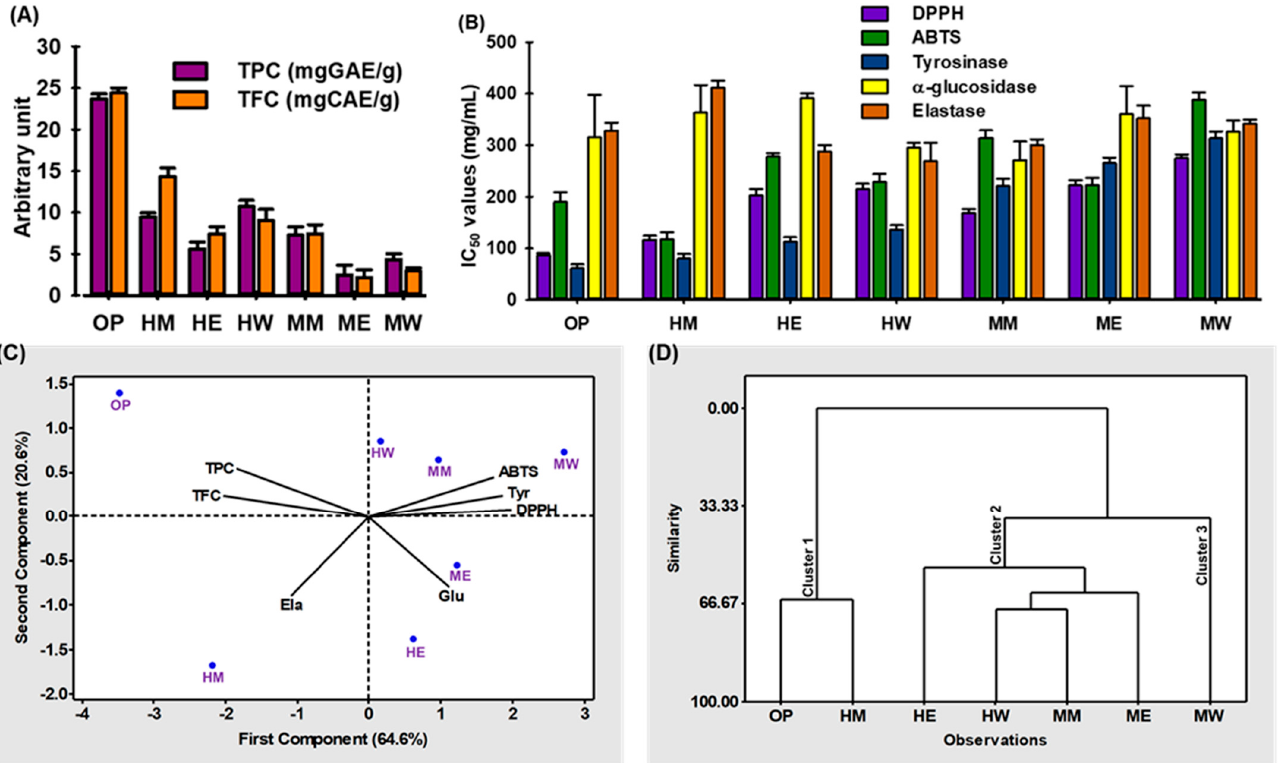
Figure 3. The pharmacological activities of the different extracts of URADP. ( A ) Total phenolic content (TPC) and total flavonoid content (TFC). ( B ) IC 50 values of DPPH–, ABTS– radical scavenging, tyrosinase, α -glucosidase and elastase enzyme inhibition activity. ( C ) Biplot (scores of samples and load factors of each variable) of the principal component analysis (PCA). ( D ) Hierarchical cluster analysis (HCA). OP: heat extract with optimized condition, HM: heat extract with 100% methanol,